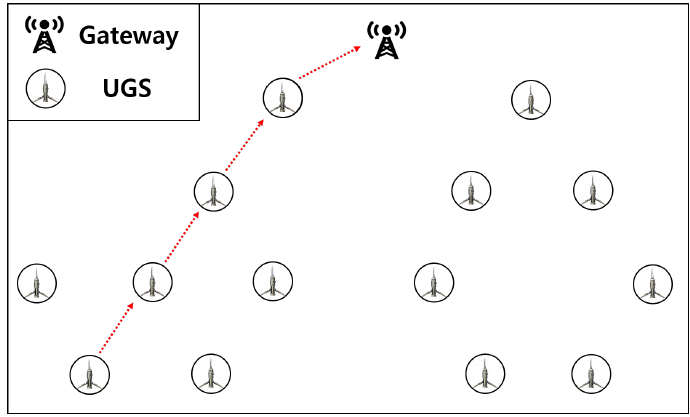
Figure 1. Illustration of a tree-based tactical wireless sensor